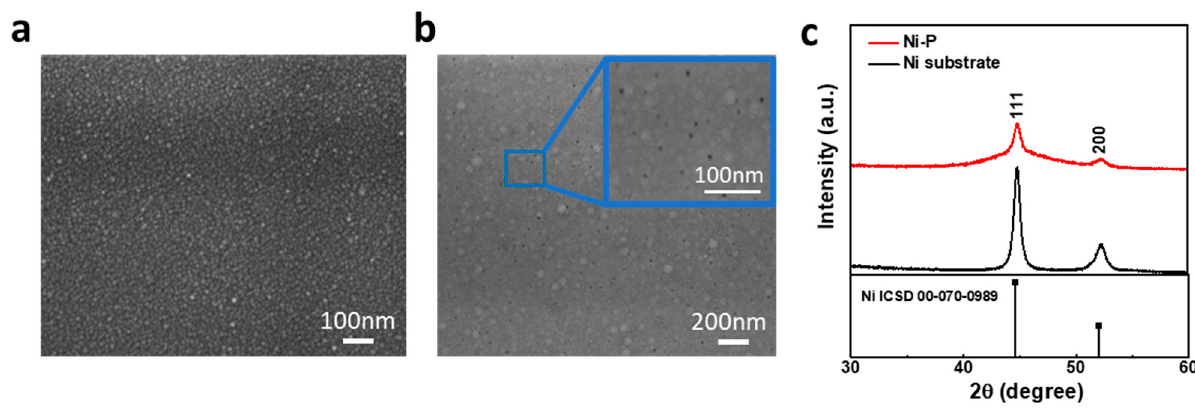
Figure 1. SEM images of ( a ) Ni substrate and ( b ) Ni–P 24 deposited for 6 min. ( c ) X-ray diffraction patterns of electroless- deposited Ni–P (red pattern) and Ni substrate (black pattern).